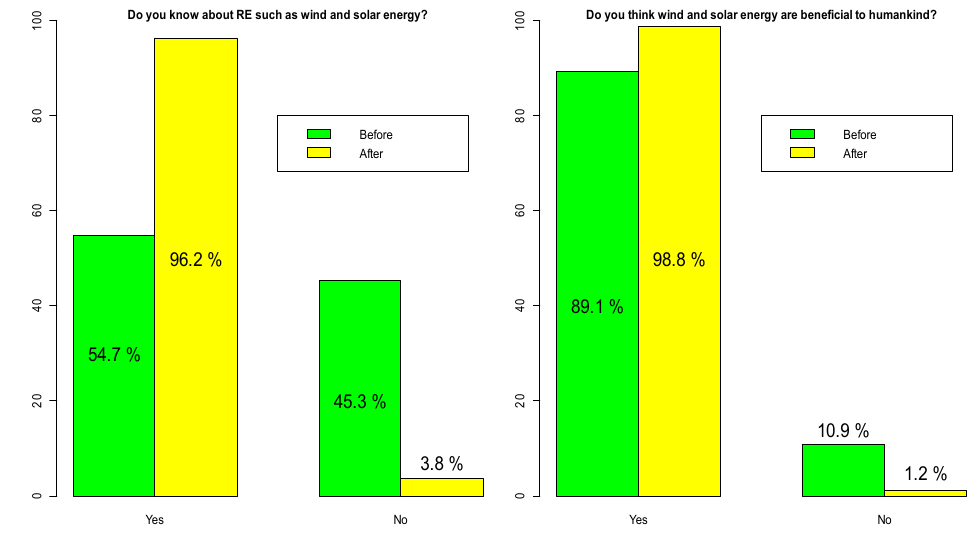
Figure 13. Respondents’ general knowledge of RE before and after RE implementation at EKOMAR.